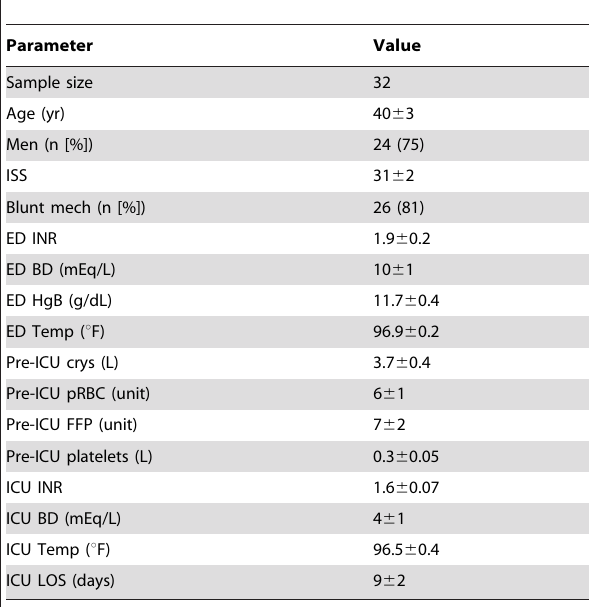
Table 1. Shock Resuscitation